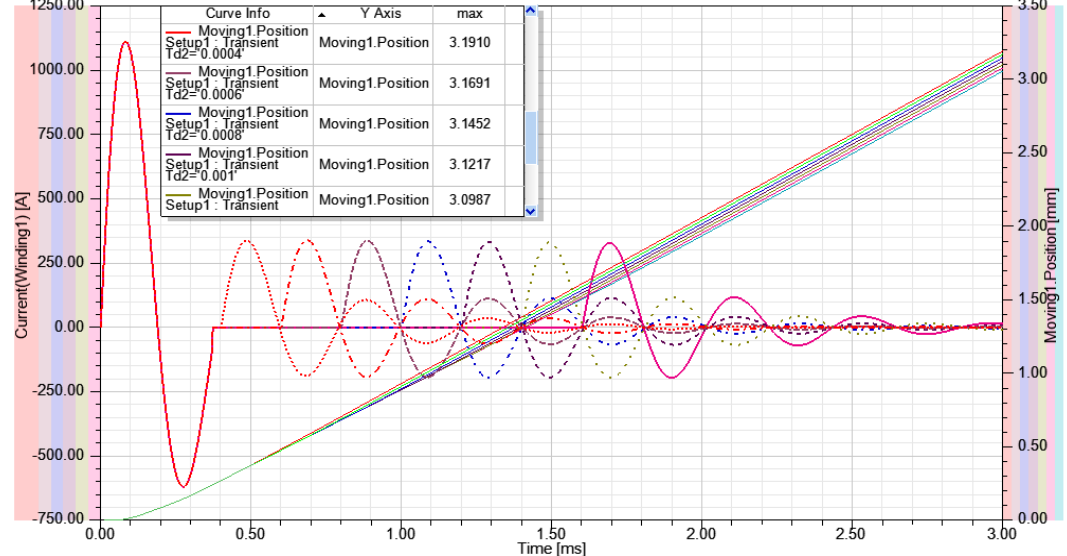
Figure 11. Coil current family and displacements corresponding to it ( Uc = 800 V), (Case 2 from Table 2).